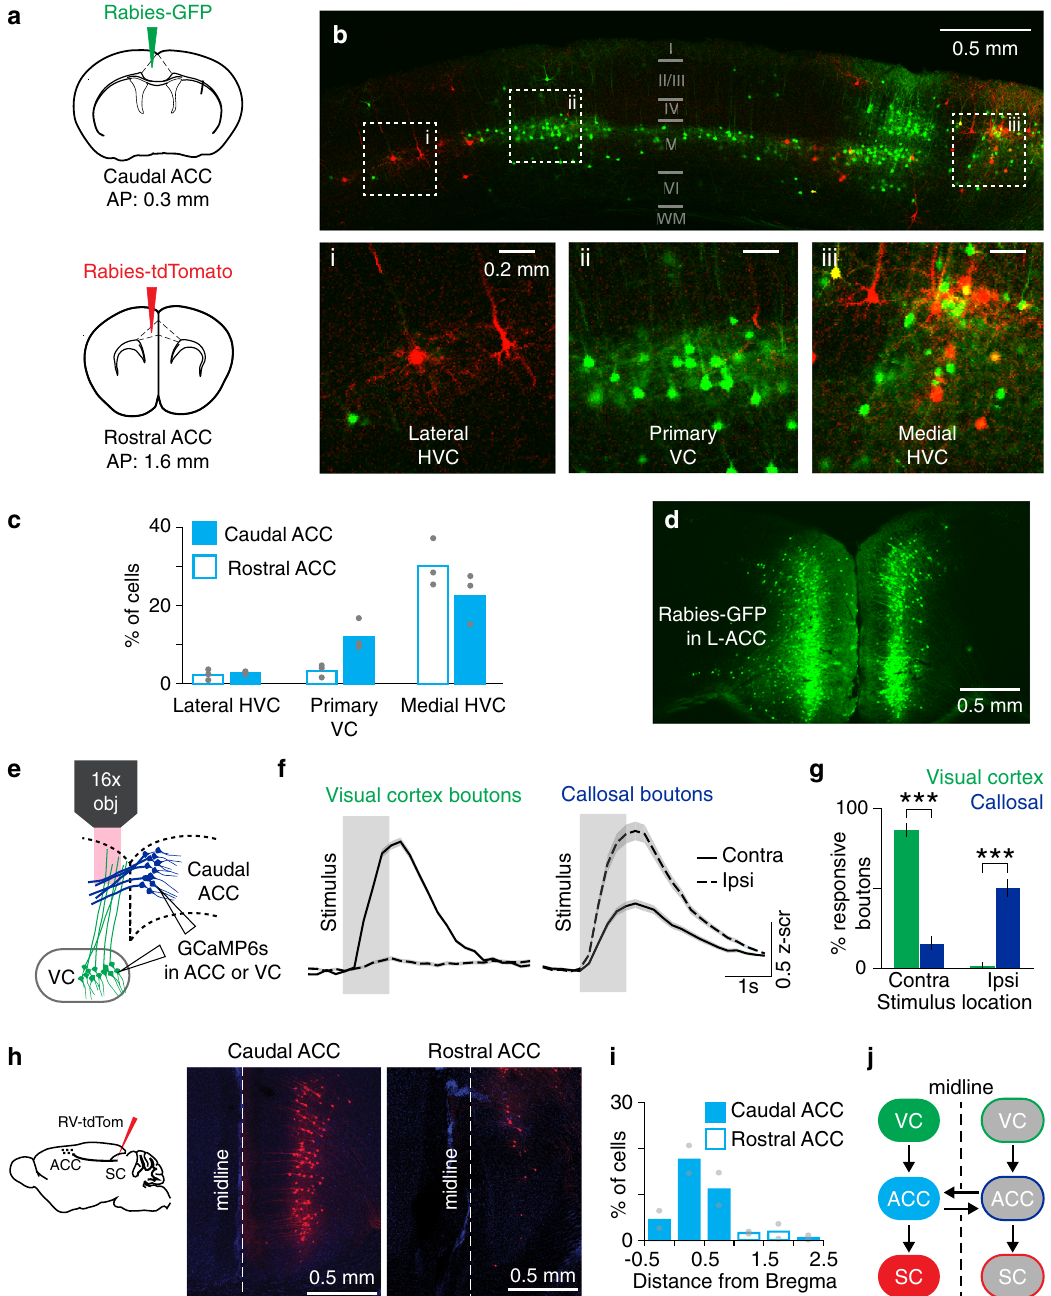
Fig. 1 Anatomical and functional characterization of inputs to and outputs from the ACC. a Rabies viruses encoding green fl uorescent protein (GFP) or tdTomato were injected into caudal or rostral left anterior cingulate cortex (ACC), respectively. b Imaging of back-labeled neurons in the left visual cortex (green, GFP; red, tdTomato). Neurons in lateral higher VC (HVC), primary VC, or medial HVC are denoted by dotted squares (i-iii) on top and shown at higher magni fi cation on the bottom. Similar results were observed across the three mice tested. c Proportion of back-labeled neurons in various VC subdivisions projecting to caudal (solid) or rostral (un fi lled) ACC ( n = 3 mice). d Back-labeled callosal neurons following injection in the left caudal ACC (L-ACC). Similar results were observed across the three mice tested. e Experimental setup for two-photon imaging via a 16× objective (obj) of GCaMP6s-expressing visual cortex (VC) or callosal axons in the ACC while head- fi xed mice passively viewed visual stimuli (black square or grating, ~20°) presented in either hemi fi eld. f Population-averaged responses of visually driven VC ( n = 268 boutons from four mice) and callosal ( n = 309 boutons from fi ve mice) boutons to stimuli presented in contralateral (contra) or ipsilateral (ipsi) hemi fi elds. Solid or dashed line is the mean response and shading shows the standard error of the mean. g Percent of visually driven VC and callosal boutons with preferential responses to contra (VC, n = 233/268 from four mice; callosal, n = 48/309 from fi ve mice; p ~ 10 − 72 ) and ipsi stimuli (VC, n = 4/268 from four mice; callosal, n = 156/309 from fi ve mice; p ~ 10 − 47